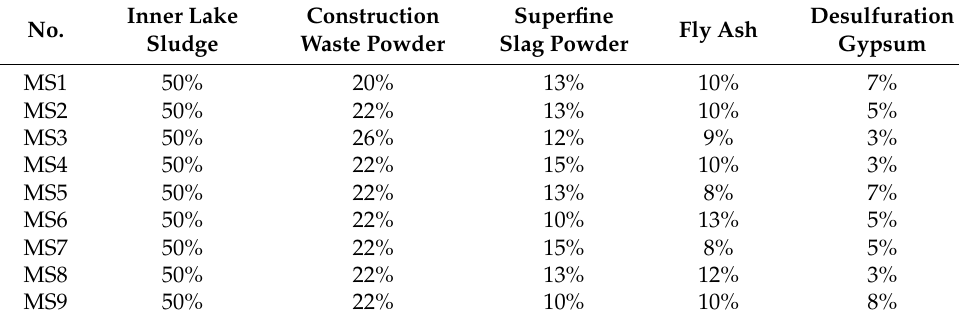
Table 2. Material mix proportion of modified dredged